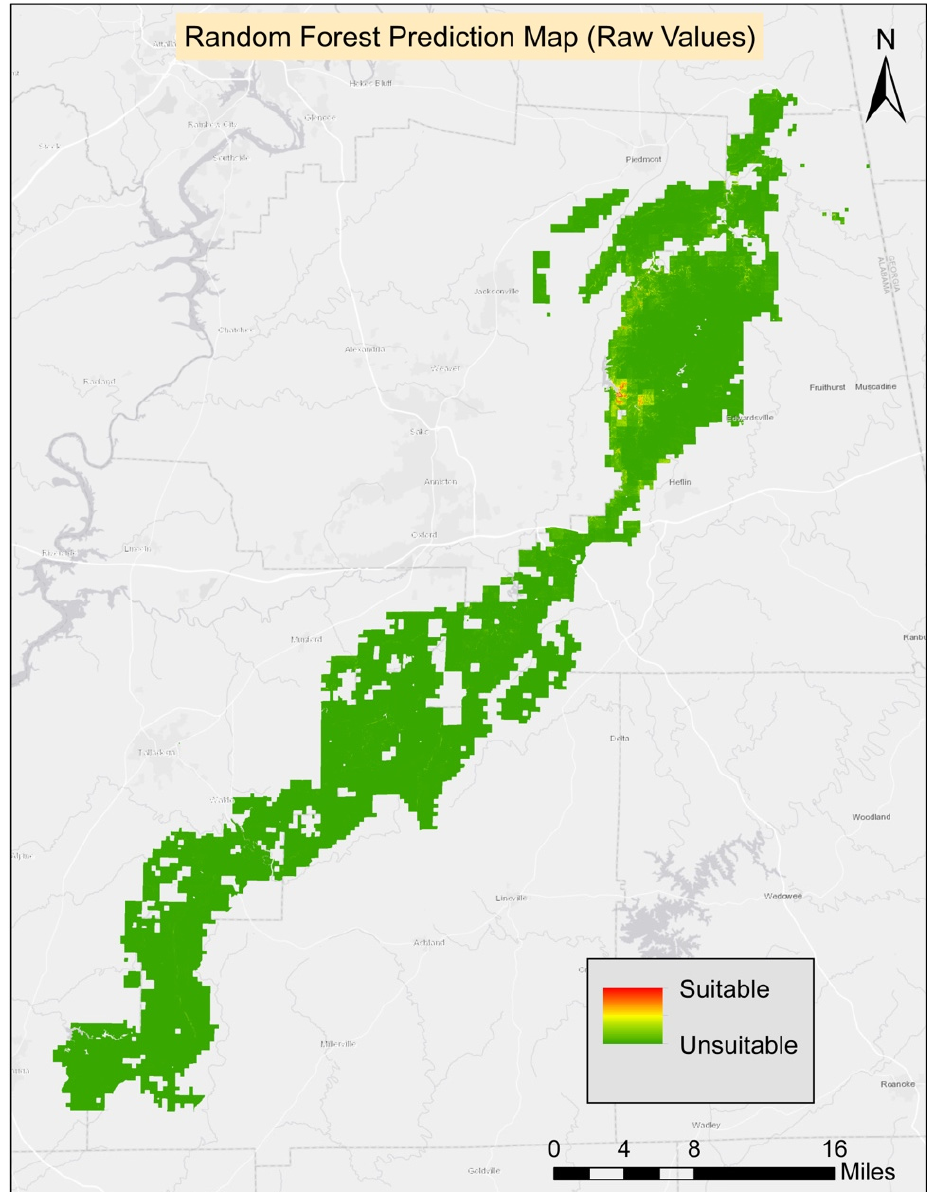
Figure A5. Xerophyllum asphodeloides (turkeybeard) Random Forest model habitat suitability map.